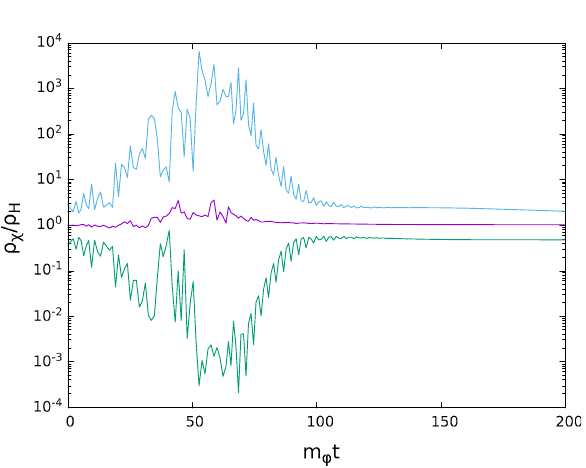
Fig. 2 Plot of energy fraction ratios versus m φ t . Left m φ = 10 − 6 M Pl , λ φ = 10 − 14 , λ φχ = 10 − 7 , λ φ H = 10 − 7 , λ H = 10 − 7 , σ φ = 10 − 10 M = 10 − 6 M , λ φ = 10 − 14 , λ φχ = H Pl . Right m φ Pl